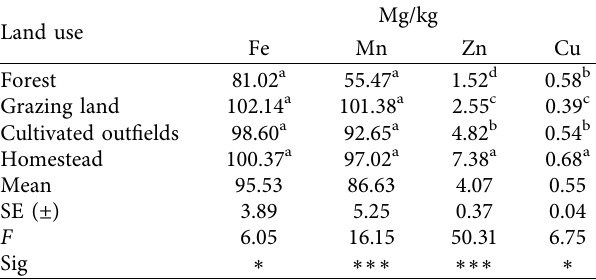
Table 6: Mean values of selected micronutrients as affected by different land use classes. Land use Grazing land Cultivated outfields